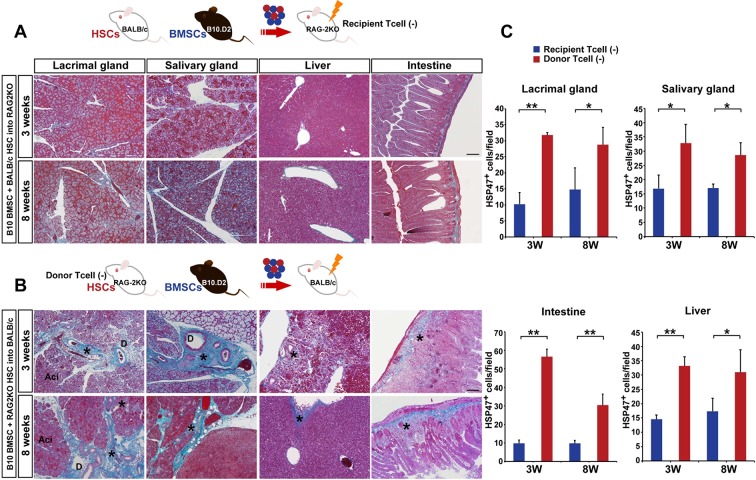
Host T cells are required for the progression of fibrosis.(A) Mallory staining of recipient RAG2KO organs shows that transplantation of mismatched BMSCs did not induce fibrosis in the absence of recipient T cells. Scale bar, 100 μm. (B) Tissue inflammation and excessive fibrosis in deep blue (*) was observed in BALB/c recipient mice after B10.D2 BMSC and RAG2KO HSC transplantation, despite the lack of donor T cells. Data collected from two replicate experiments (n = 3 per group). Scale bar, 100 μm. (A, B) D, duct; Ac, Acinus. (C): Significantly higher number of HSP47+ fibroblasts was observed in BALB/c recipients after B10 BMSC + RAG2KO HSC transplantation (red) compared to RAG2KO recipients after B10 BMSC + BALB/c HSC transplantation (blue). Data from five different fields in two replicate experiments. Data are shown as mean ± SD. *p<0.01, **p<0.001.DOI:
http://dx.doi.org/10.7554/eLife.09394.01610.7554/eLife.09394.017Figure 3—source data-1.Number of HSP47+ cells per field from the lacrimal gland, salivary gland, liver, and intestine.Source data for graphs in (C). HSP, heat-shock protein.